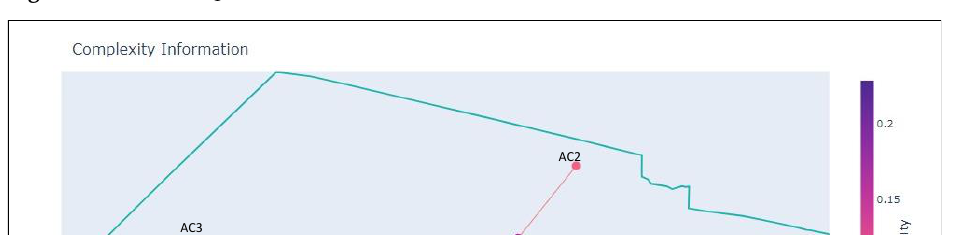
Figure 10. Sector at t 1 .